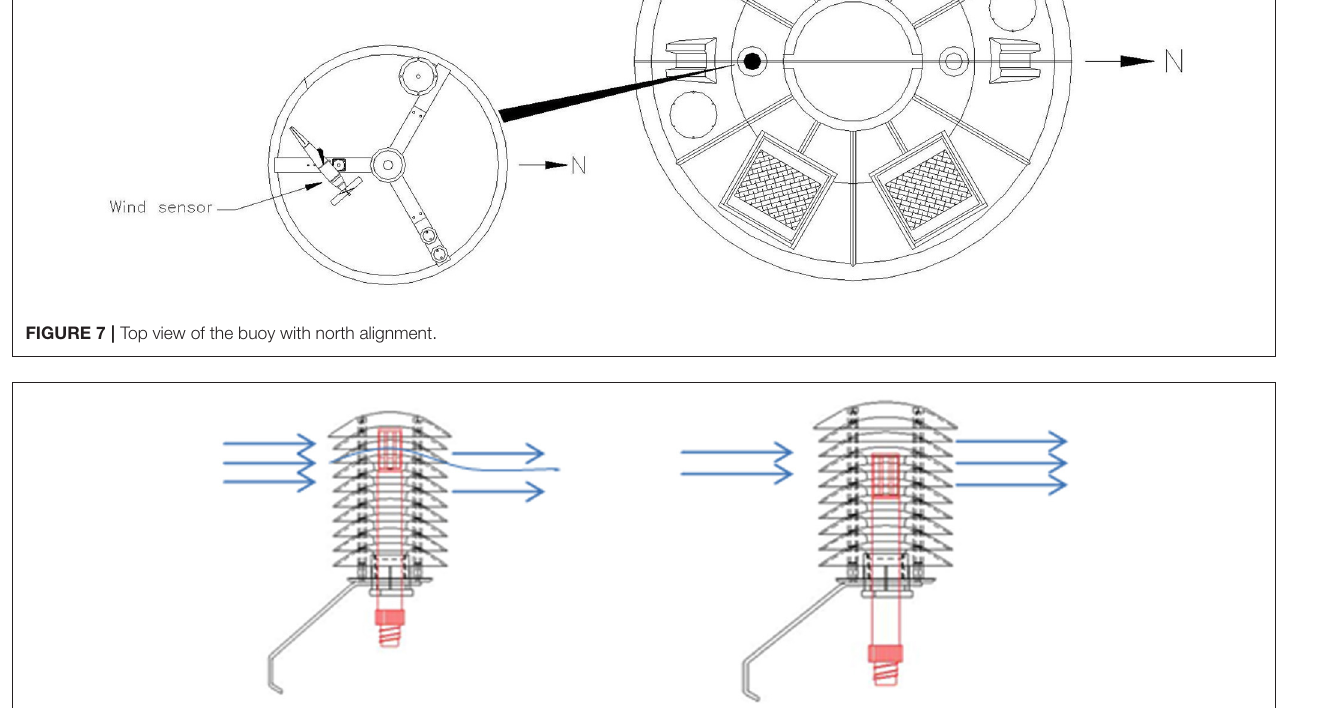
FIGURE 8 | Humidity sensor placement in the radiation